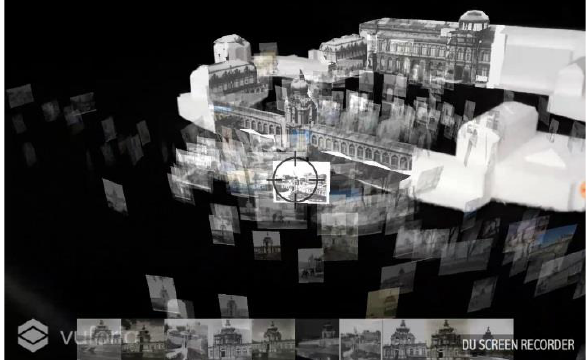
Figure 5 . Visualizing the distributions of positions and orientations of aggregations of photographs.